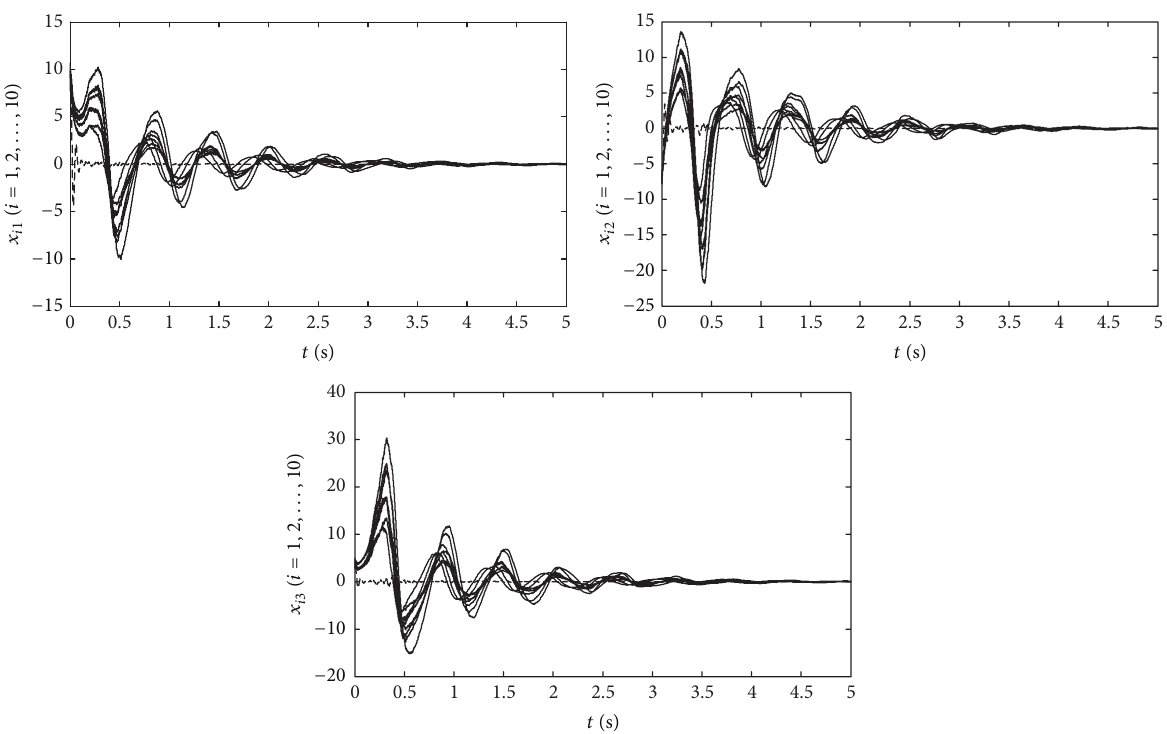
Figure 2: The states of complex network with a symmetric irreducible coupling matrix 𝐶 .